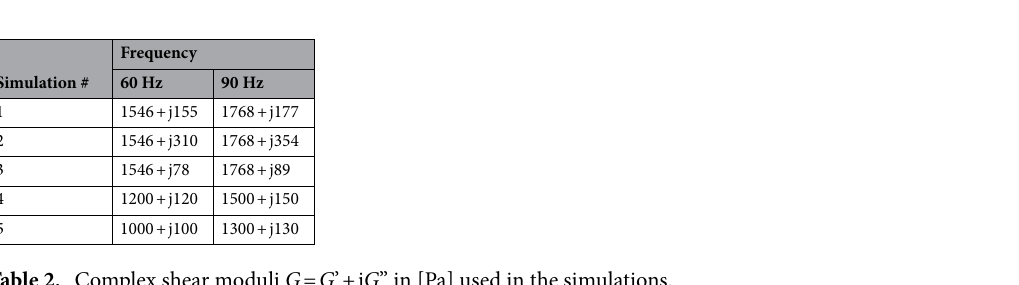
Table 2. Complex shear moduli G = G ’ + j G ” in [Pa] used in the